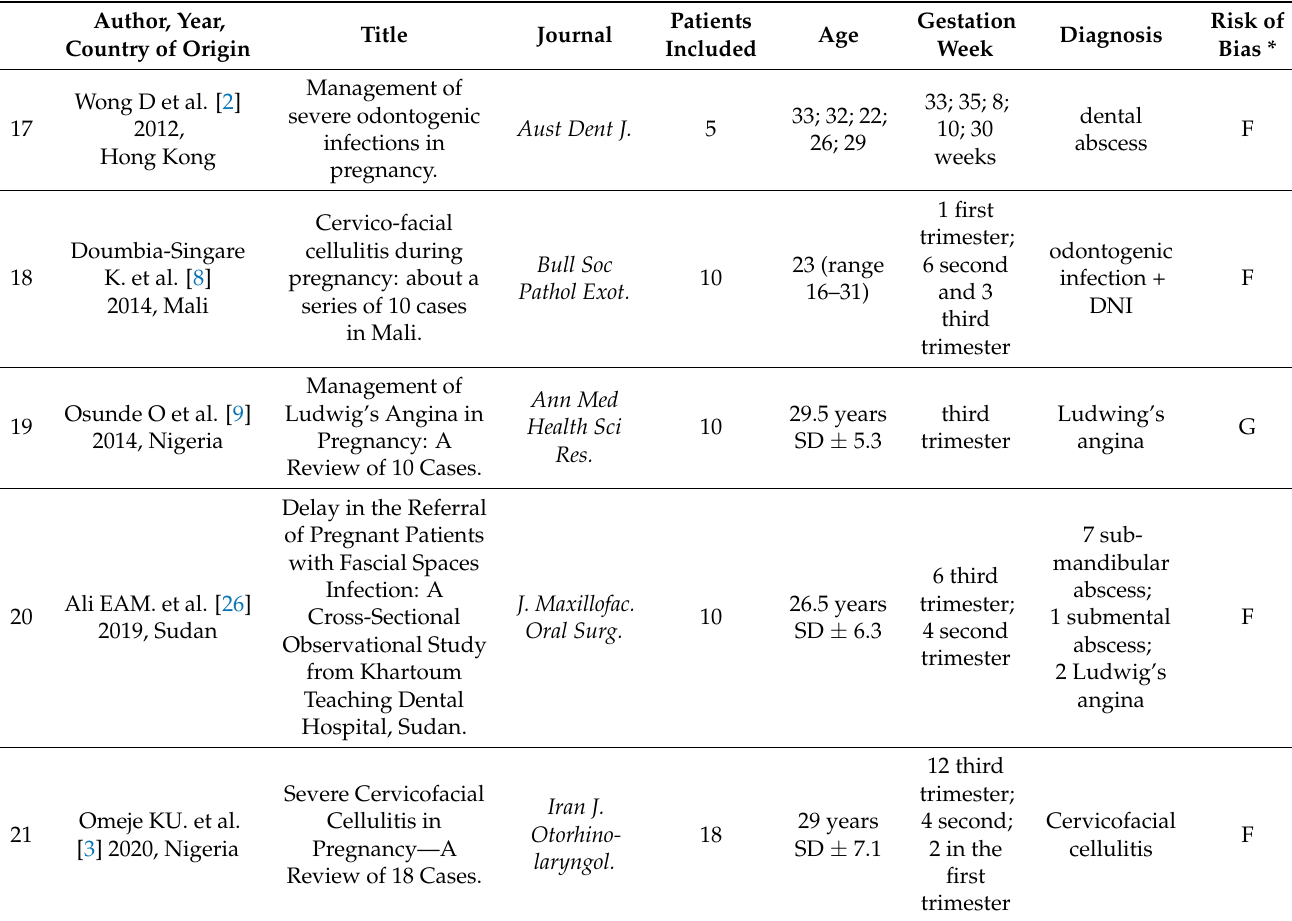
Table 2. Characteristics of included retrospective